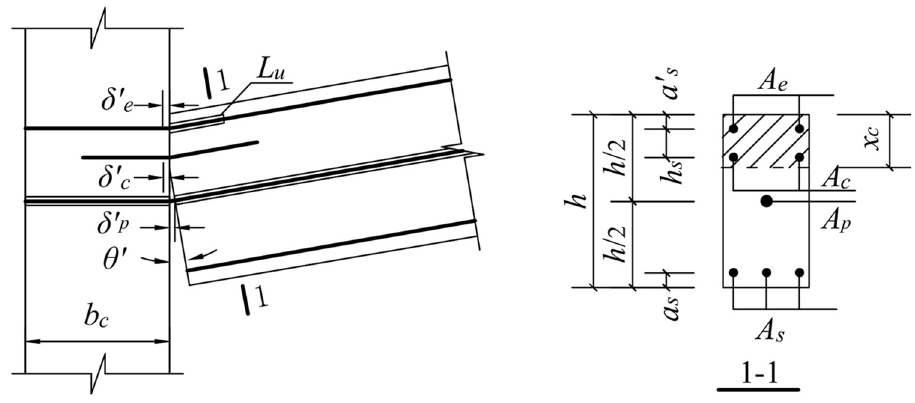
Fig 27. Mechanical model for upward